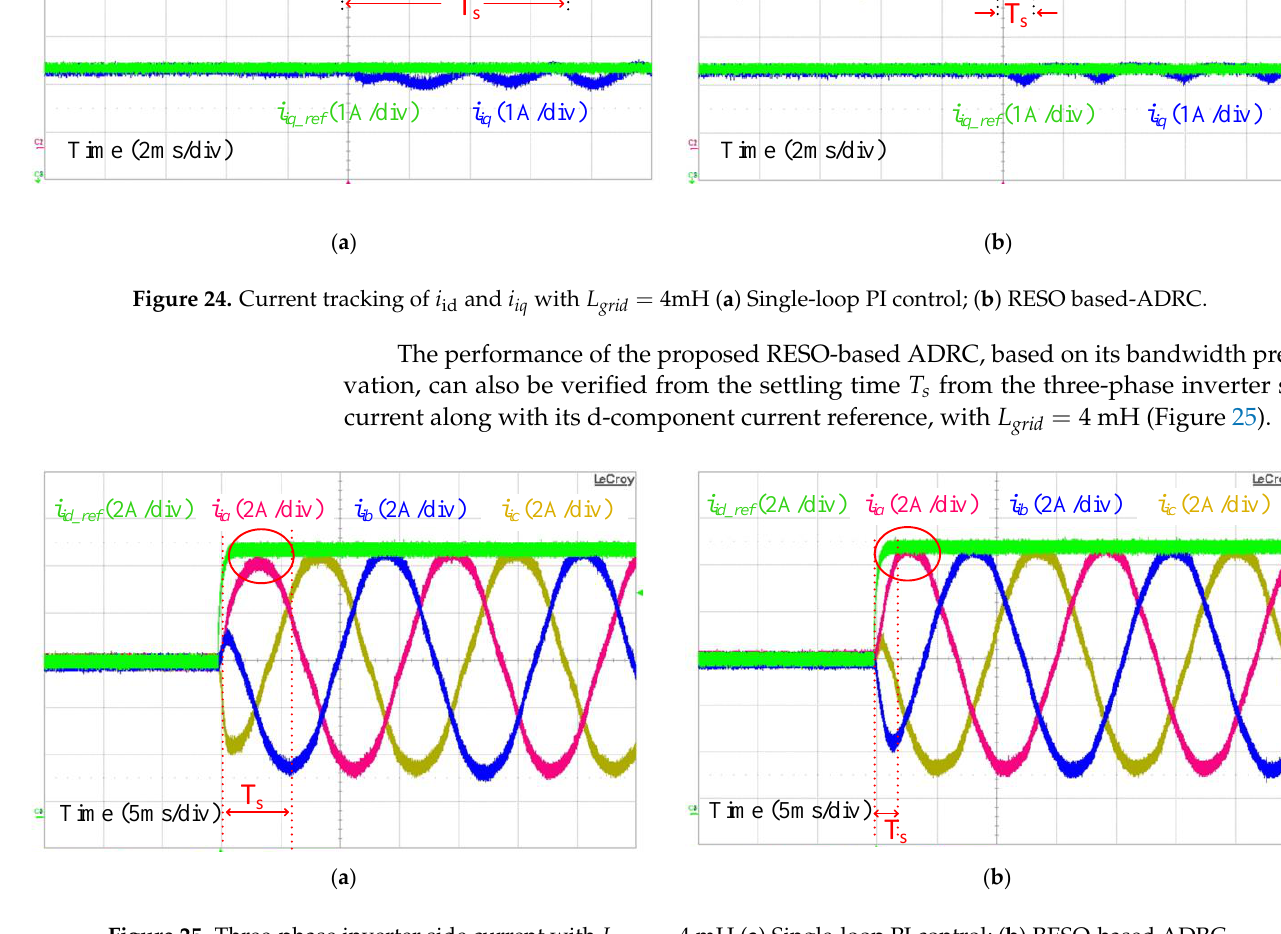
Figure 25. Three-phase inverter side current with L grid = 4 mH ( a ) Single-loop PI control; ( b ) RESO-based ADRC.